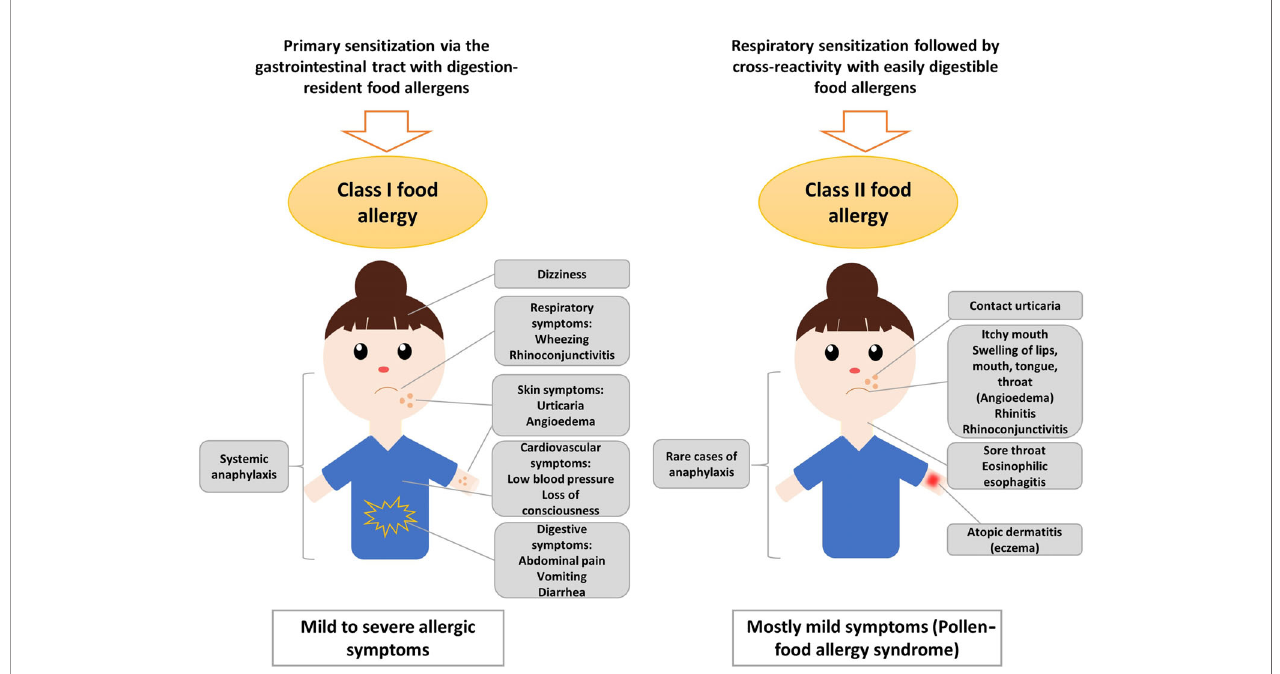
FIGURE 1 | Sensitization to class I and class II nut allergens is associated with different clinical symptoms. Sensitization to class II nut allergens usually occurs by respiratory sensitization to cross-reactive respiratory allergens (e.g., pollen allergens) and is associated with mild symptoms such as oral allergy syndrome, local reactions in the oropharynx, esophagus and may trigger atopic dermatitis and/or urticaria. Sensitization to class I digestion-resistant nut allergens usually occurs via the gastrointestinal tract and eventually via the skin and is associated with systemic and severe manifestations such as anaphylaxis but also mild symptoms are